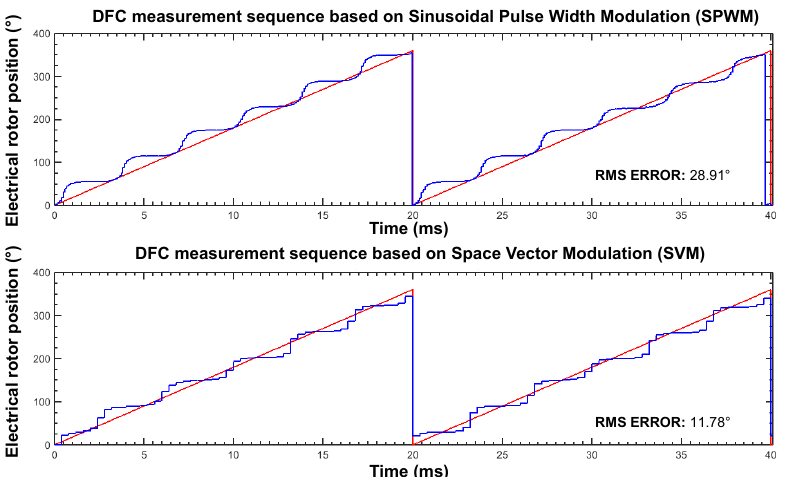
Figure 12. Rotor position estimation, comparison between DFC measurement sequence based on SPWM (Figure 2) and DFC based on SVM (see Figure 5).